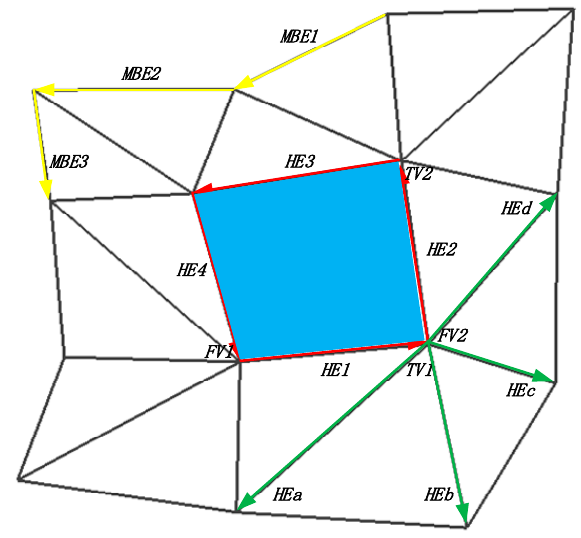
Figure 4. Schematic diagram of simple hole-detection. The hole-area was filled with blue and the red directed lines HE1, HE2, HE3, and HE4 are its boundary half-edges. The yellow directed lines MBE1, MBE2, and MBE3 and so on represent the boundary half-edges of the model. There are eleven boundary half-edges in this simple model, and we have been drawn. In addition, the four border half-edges that were unselected are still shown in the figure with green directed lines. The half-edge HE1 was randomly selected as the starting half-edge, and FV1 is the starting-vertex of it and TV1 is the ending-vertex.